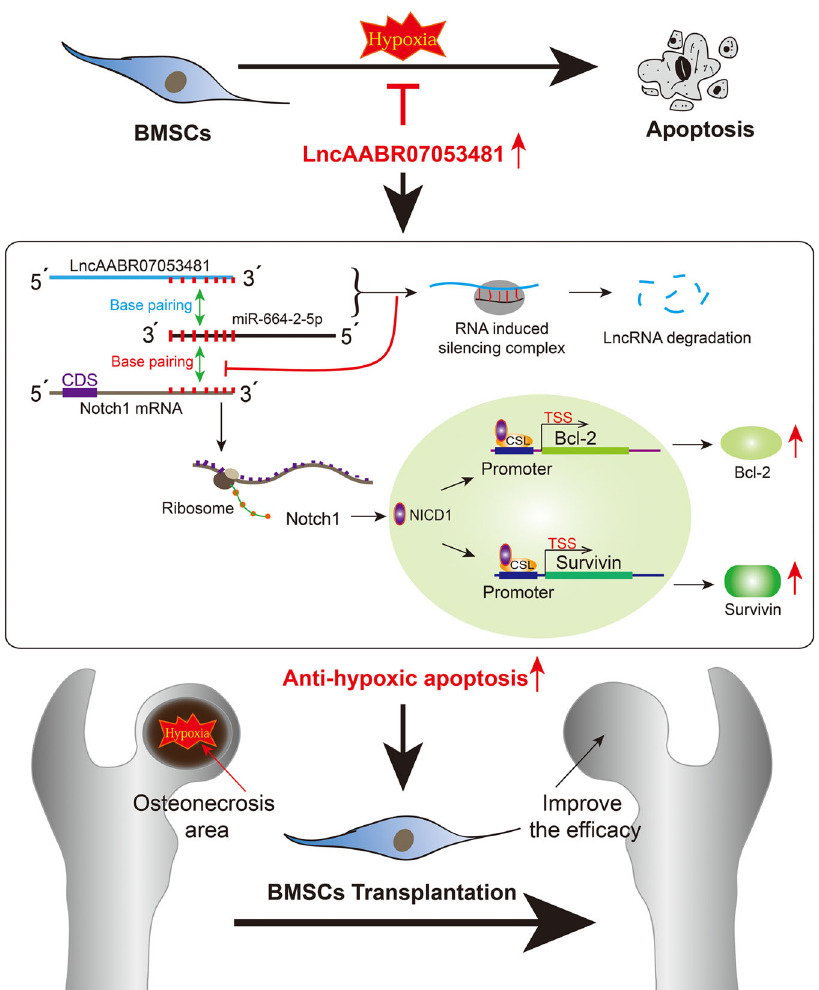
Fig. 7 Effect and mechanism of LncAABR07053481 on the repair of early SANFH by regulating the Notch1 pathway to inhibit hypoxia-induced apoptosis of BMSCs: LncAABR07053481 acts as a sponge for miR-664-2-5p to attenuate its repressive effect on Notch1 and activates the Notch1 pathway and releases NICD1 (the intracellular active fragment of Notch1 ) from the cell membrane. NICD1 localizes to the nucleus, where it forms a transcriptionally active complex with the DNA-binding protein CSL and the coactivator Mastermind (MAM) to upregulate transcription of Notch target genes (Survivin and Bcl-2). Following which, hypoxia-induced apoptosis of BMSCs in the area of osteonecrosis is inhibited, improving the transplantation effect of BMSCs on early